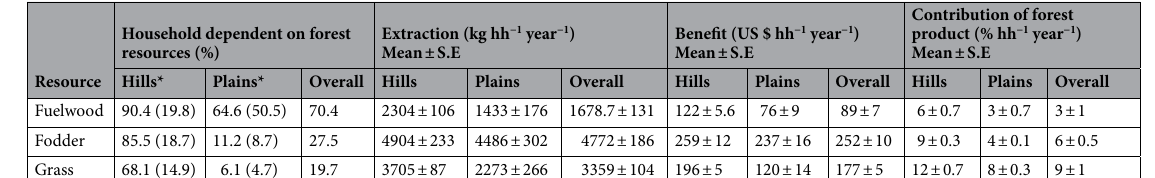
Household dependent on forest resources Resource